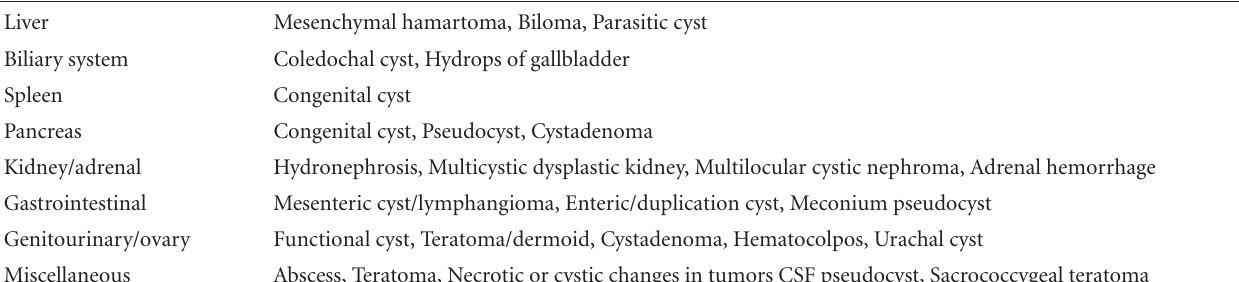
Table 1: Di ff erential diagnosis of cystic abdominal masses in children (from Wooton-Gorges et al. [3]). Liver